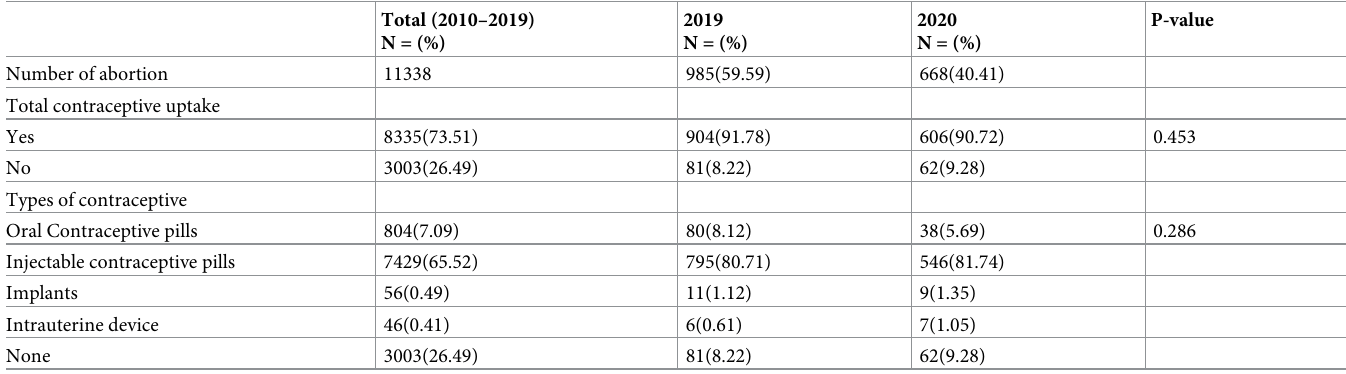
Table 4. Comparison of pattern of Contraceptive uptake during the pre-COVID-19 and intra-COVID-19 era.